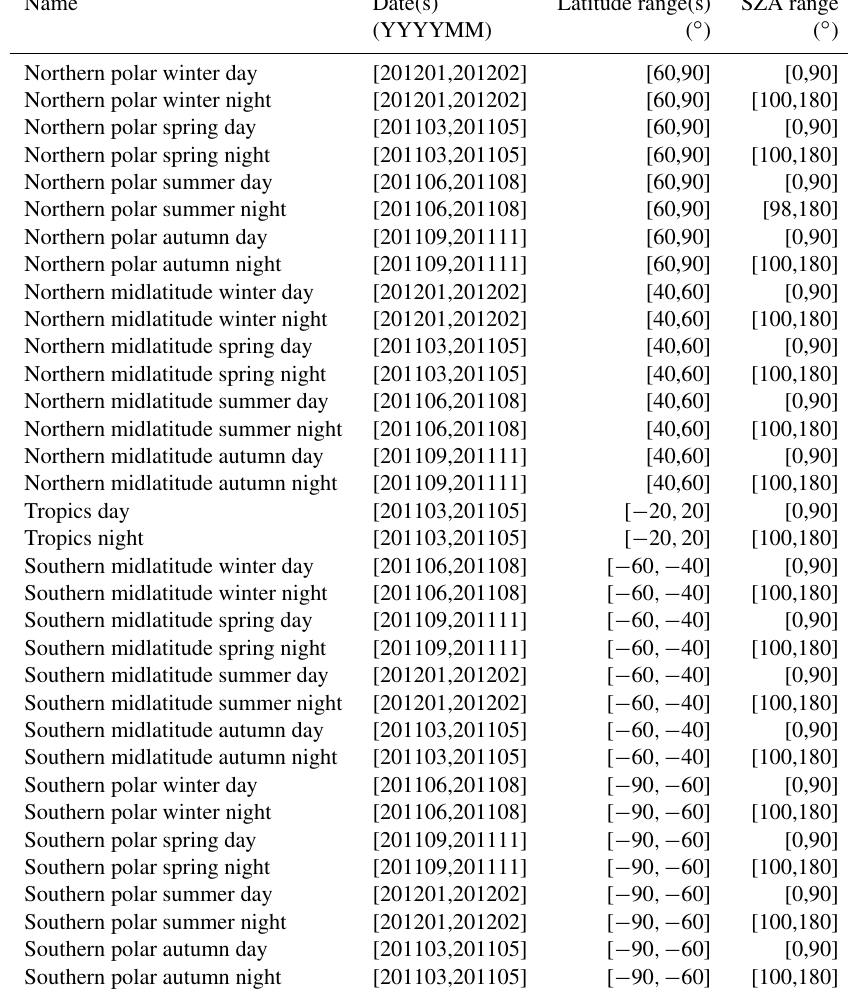
Table A5. Measurements used for error analysis of upper atmosphere measurements during high solar